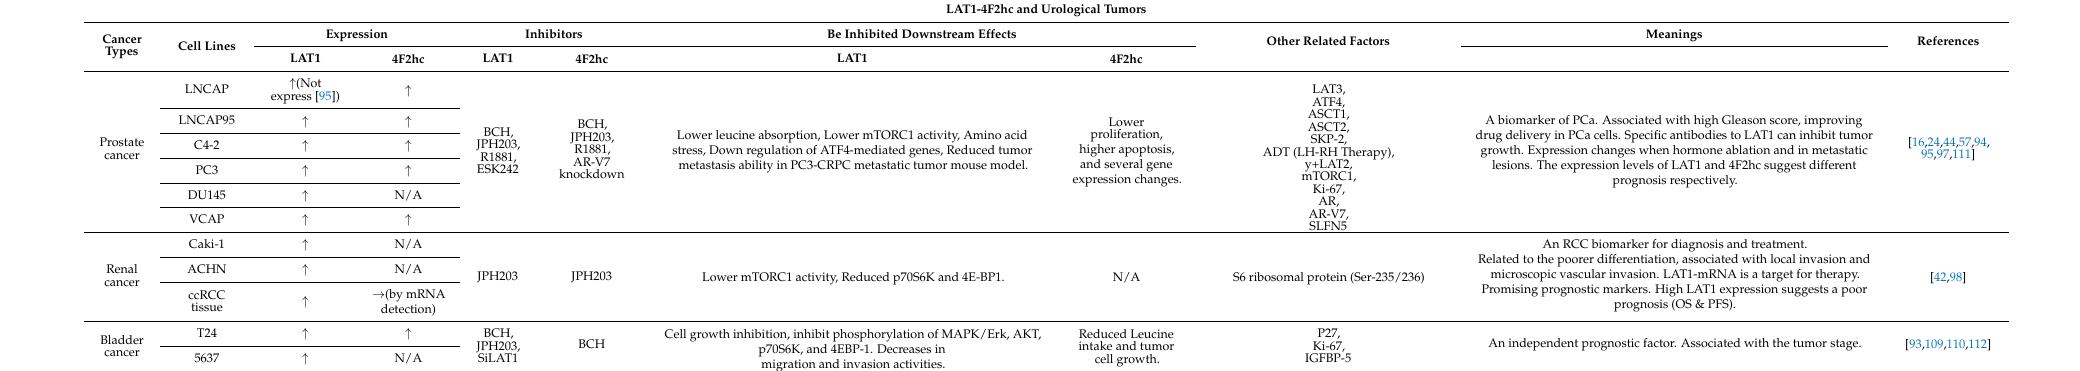
Table 2. LAT1-4F2hc and Urological